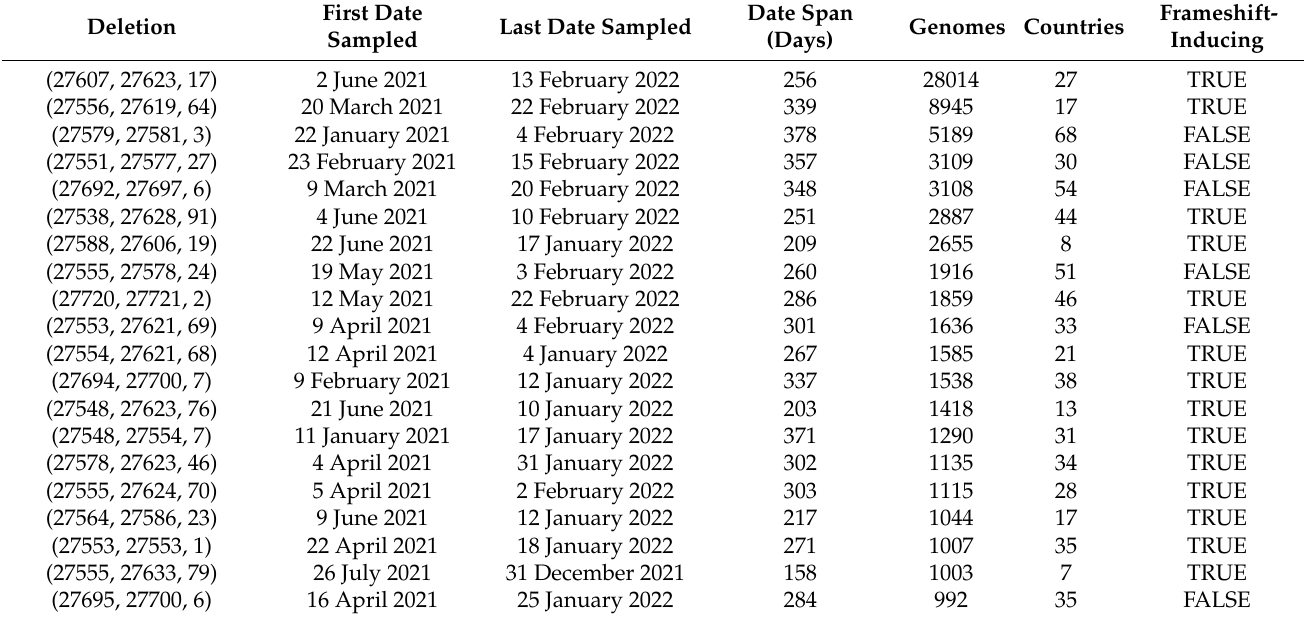
Table 1. The top 20 deletions in ORF7a of Delta genomes in GISAID clade GK (as of 31 May 2022) ranked by the number of genomes in which they were found. Deletions are summarised in shorthand format in the form of start coordinate, end coordinate, and overall length in the nucleotides. The deletion that characterised the Australian Delta outbreak (Delta-ORF7a ∆ 17del ) is represented by “(27607, 27623, 17)” in the first row. Accession numbers for all the samples that were analysed for this table are available in Table S1 and https://doi.org/10.55876/gis8.220809bs.